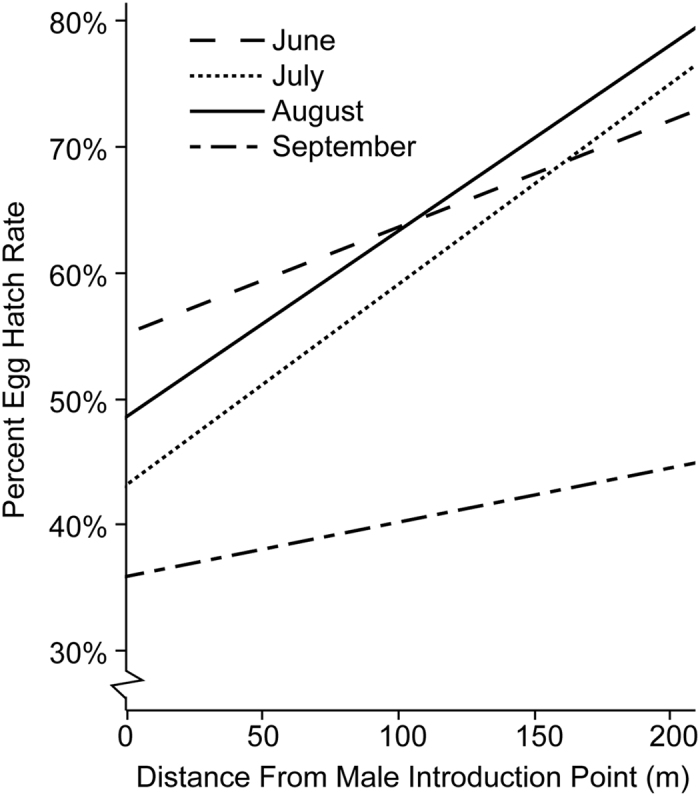
Egg hatch is correlated with distance from the male introduction point, among sites within the Treated area.Eggs that were collected closer to the male introduction point experienced a lower hatch rate in July (R2 = 0.105, F(1,129) = 14.96, p < 0.0002) and August (R2 = 0.158, F(1,118) = 21.94, p < 0.0001). Similar but non-significant trends were observed in June and September (p > 0.13).